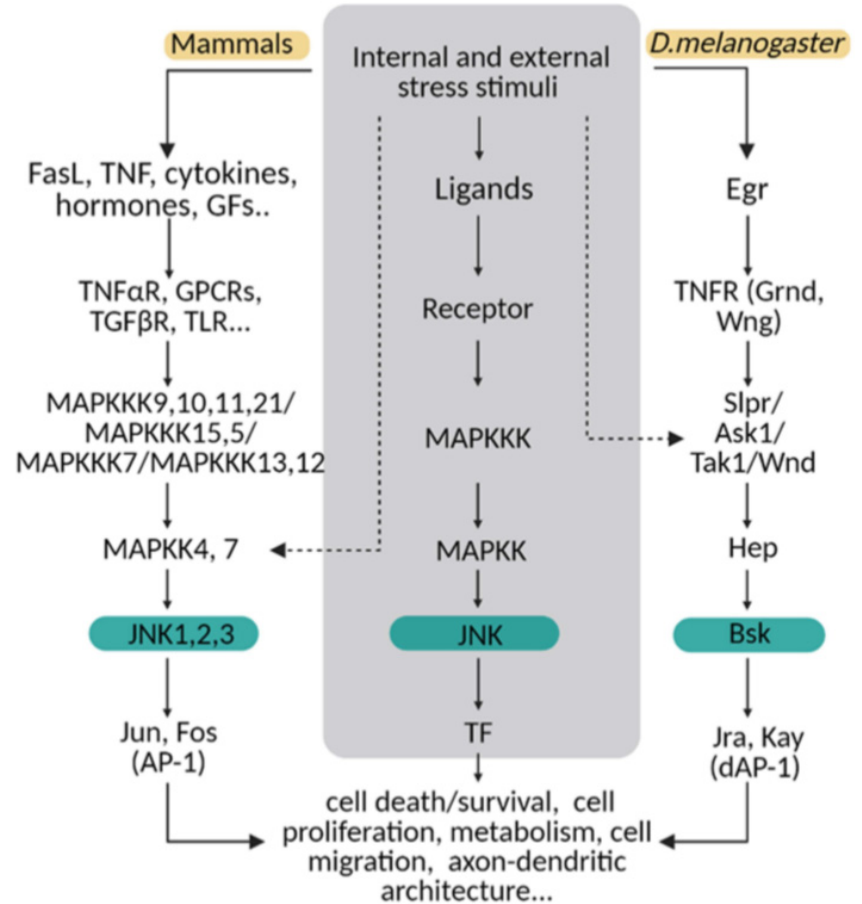
Figure 1. The JNK pathway is conserved between mammals and flies. Upon internal and external stress stimuli, ligands (ex. TNF/Egr) activate transmembrane receptors (ex. TNF α R/ Grnd) and initiate a cellular response based on a MAPK cascade phosphorylation. In mammals, different ligands can trigger the signal path; while in Drosophila, Eiger (Egr) is the TNF ligand that predominantly initiates the stress response via TNF receptors (Grindewal, Grnd; or Wengen, Wng). In mammals, there is MAPK path gene redundancy that is shown in this diagram compared with flies. MAPKs are encoded by multiple genes in mammals, whereas in Drosophila, one single gene is described for each enzyme. The cellular response converges in JNK/Bsk phosphorylation, which triggers the expression of transcription factors as Jun/Jra and Fos/Jay, known as an AP-1/dAP-1 complex. Finally, AP1/dAP-1 modulates the transcriptional program of genes involved in a variety of biological activities. This pathway can be activated at other steps indicated with dotted lines in the diagram.